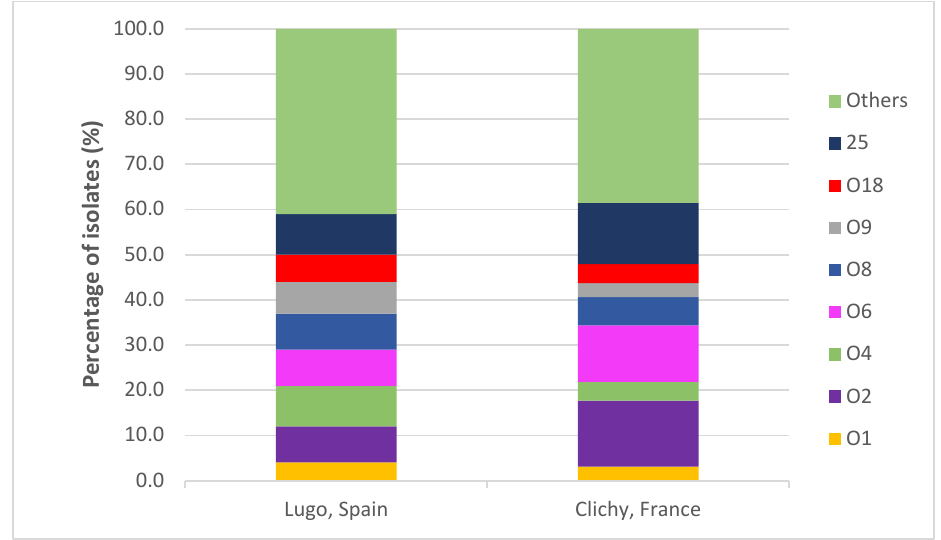
Figure 2. Comparison of the distribution of O serogroups in the two hospitals.